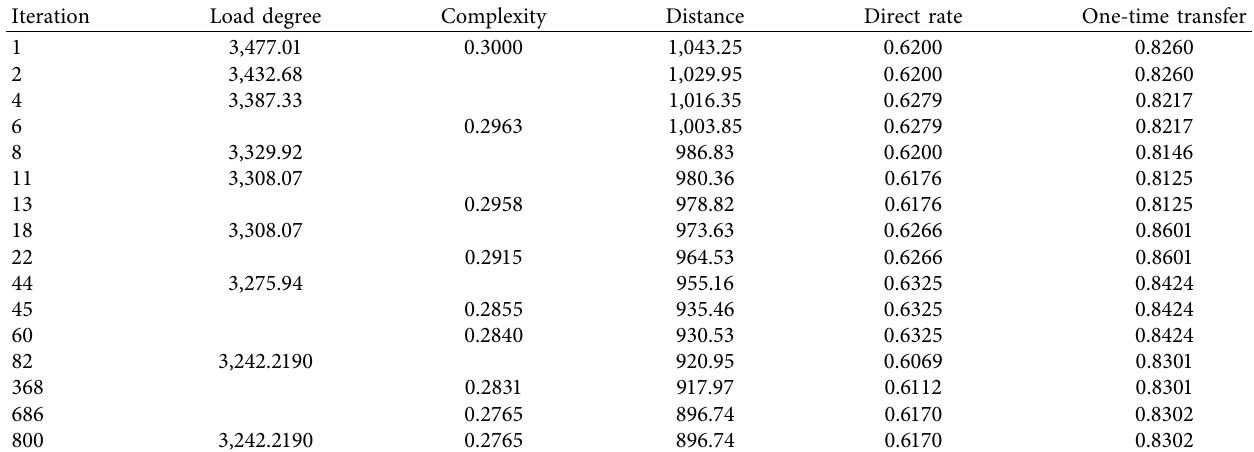
Table 4: Changes in experimental indicators.